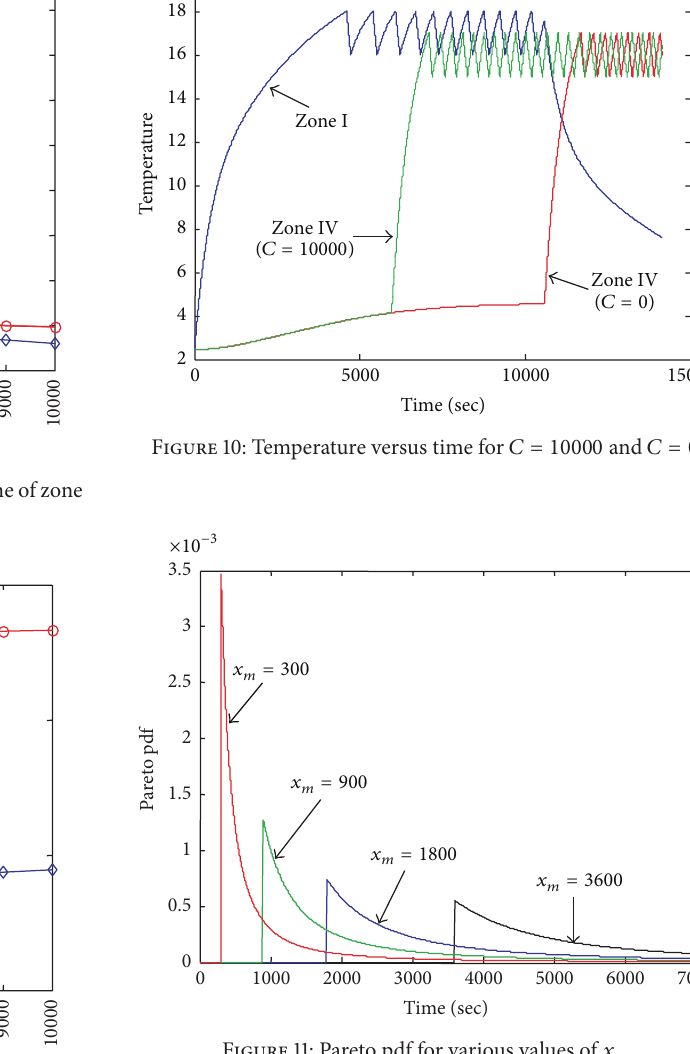
Figure 11: Pareto pdf for various values of 𝑥 𝑚